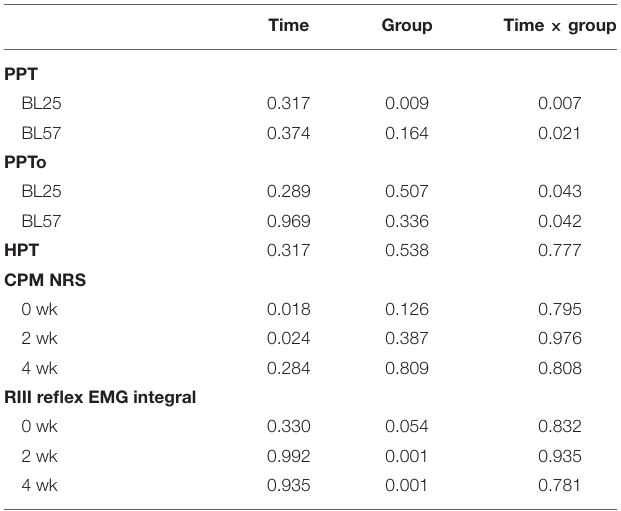
TABLE 2 | Statistical analysis: P -values from general liner models for repeated measure. Time